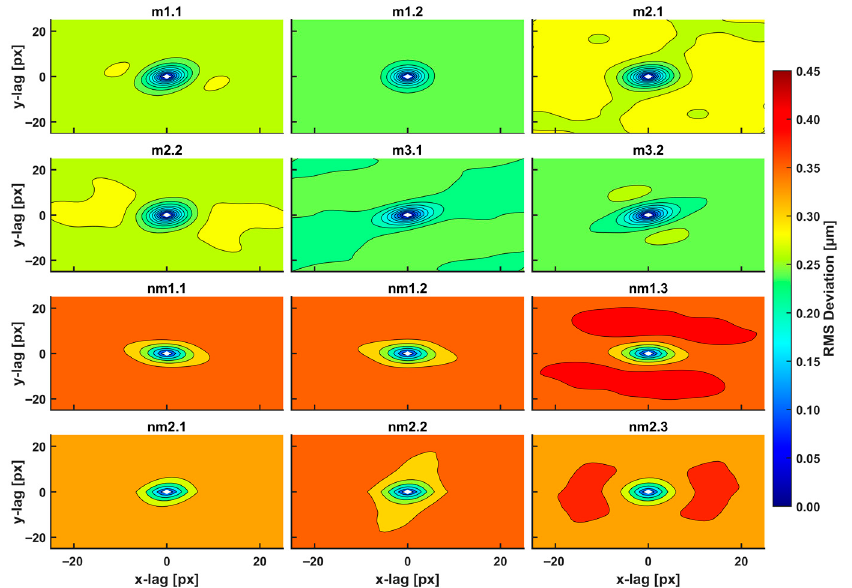
Figure 3. 2D RMS deviation spectra of metastatic/non-metastatic CRC histological sections of the AFM images (12 images shown out of 18 total), Figure 2. The spectra were taken with a 3D Gaussian high-pass filter. The RMS deviation images represent a statistical measure of the deviation of heights within an area at a particular scale. The plot shows ellipse-like contours for small scales (100 nm–1 µ m, 1–10.0 px) of equal-value RMS deviations for a given colour. Different RMS deviations from the colour index are noticeable for metastatic/non-metastatic sections. Non-metastatic CRC sections are characterized by higher values of RMS deviation within the closed and open areas compared to non-metastatic